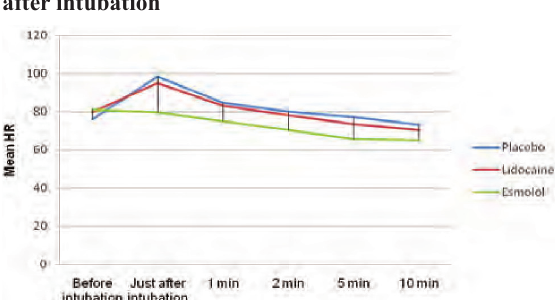
Figure 2: Comparison of mean diastolic blood pressure in the study groups before and at different time periods after intubation